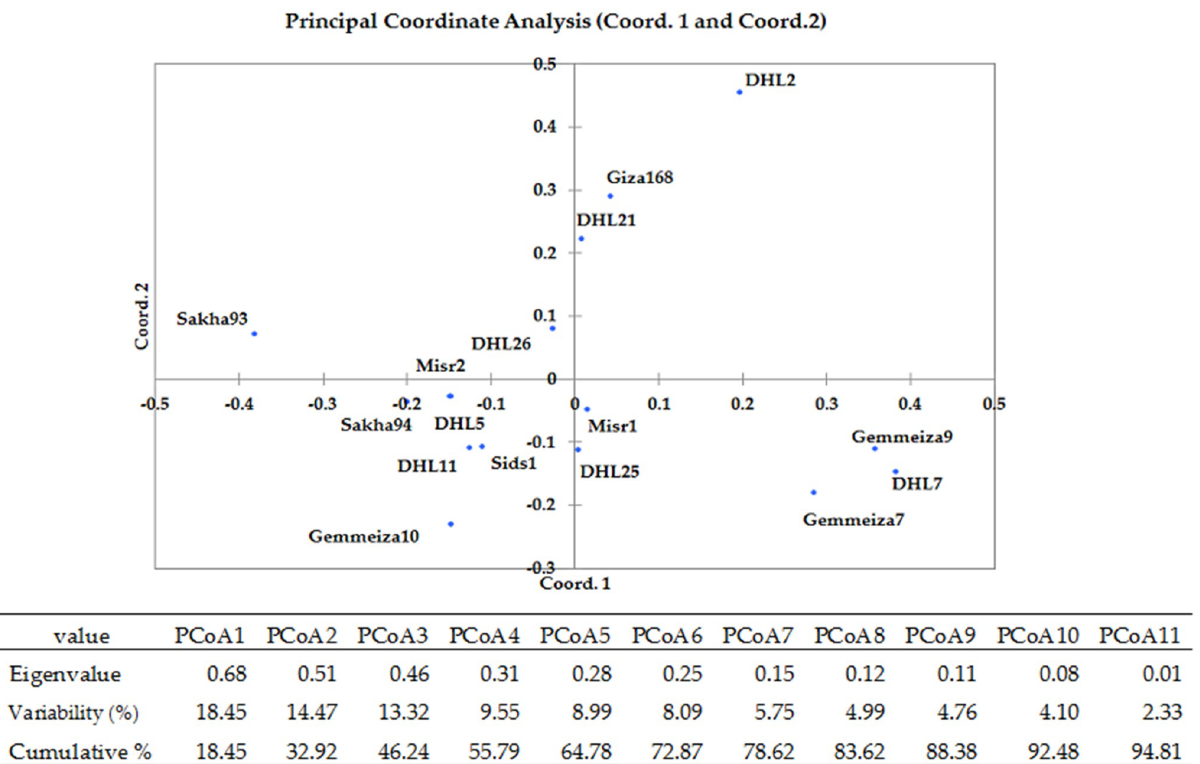
Fig 2. Principal coordinates analysis (PCoA) among the 16 wheat genotypes performed using SSR data based on Jaccard genetic dissimilarity index. DHL: Doubled haploid line.